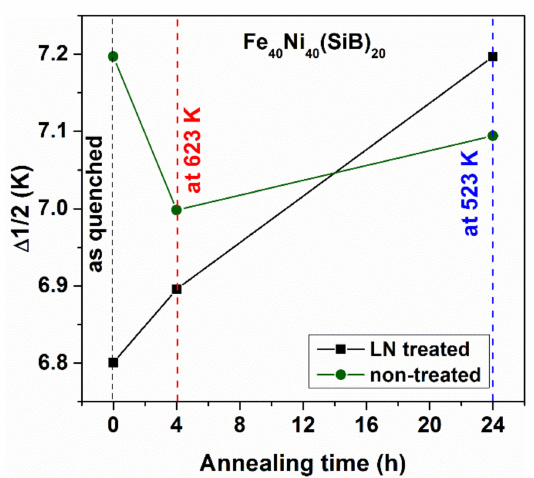
Figure 25. Change of the half width of the exothermic crystallization peak for Fe 40 Ni 40 Si 6 B 14 samples after various thermal treatments. Adopted from [98], with permission from IEEE, 2010.